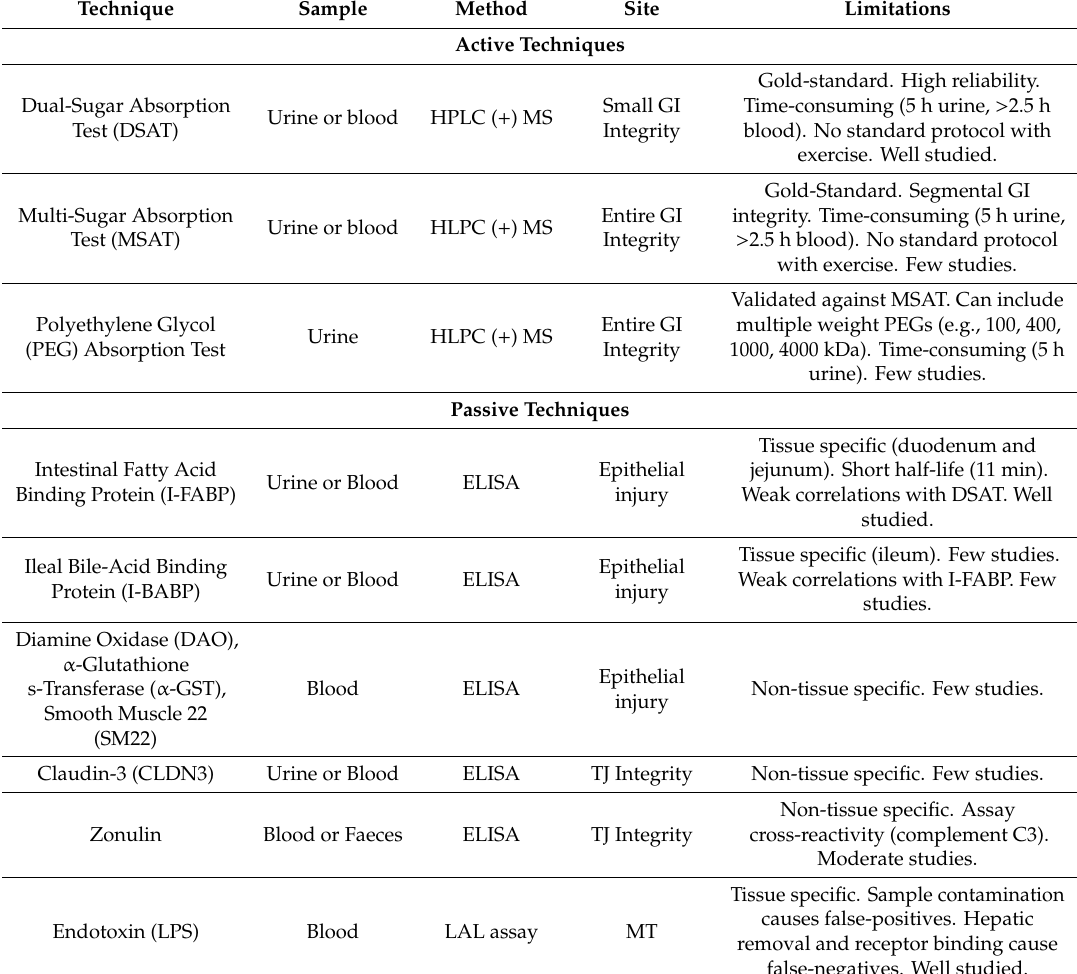
Table 1. Overview of in vivo techniques to assess GI barrier